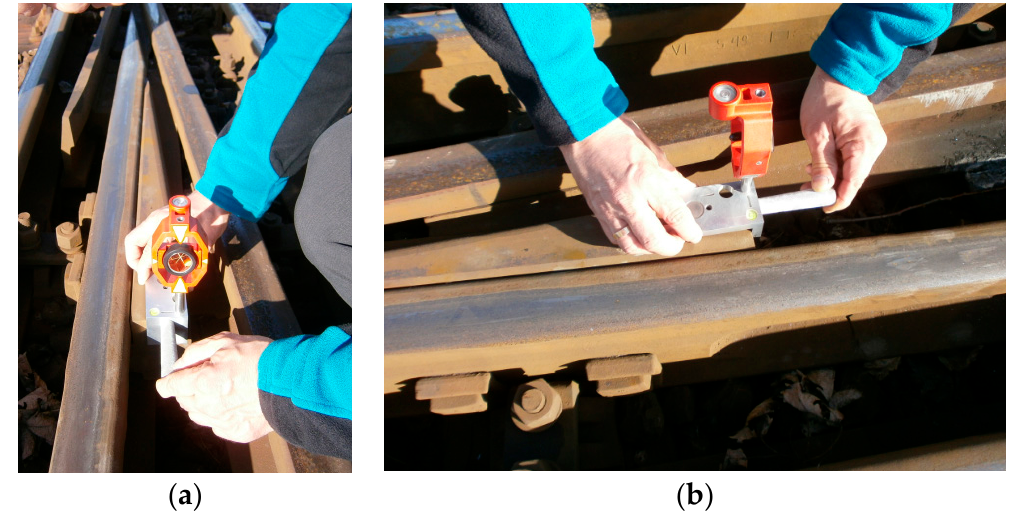
Figure 4. The Magnetic-Measuring Square (MMS) with the surveying GMP111 mini prism located on the external end of an obtuse crossing: ( a ) forward view; and, ( b ) side view. The MMS with the GMP111 mini prism and the electronic total station provided the coordinates for Points 1–12. The final stage was to obtain the angular and linear values of Rkpd iwew , which characterize the turnout geometry. A feature of the MMS is that the vertical axis of its stylus mounting hole coincides with the measuring edge and with the axis of the surveying stylus and the geometric center of the GMP111 mini prism. As a result of the neodymium magnets built into its structure, the MMS was stabilized immovably for the Rkpd iwew steel sections, providing a visualization at each measurement point (Figure